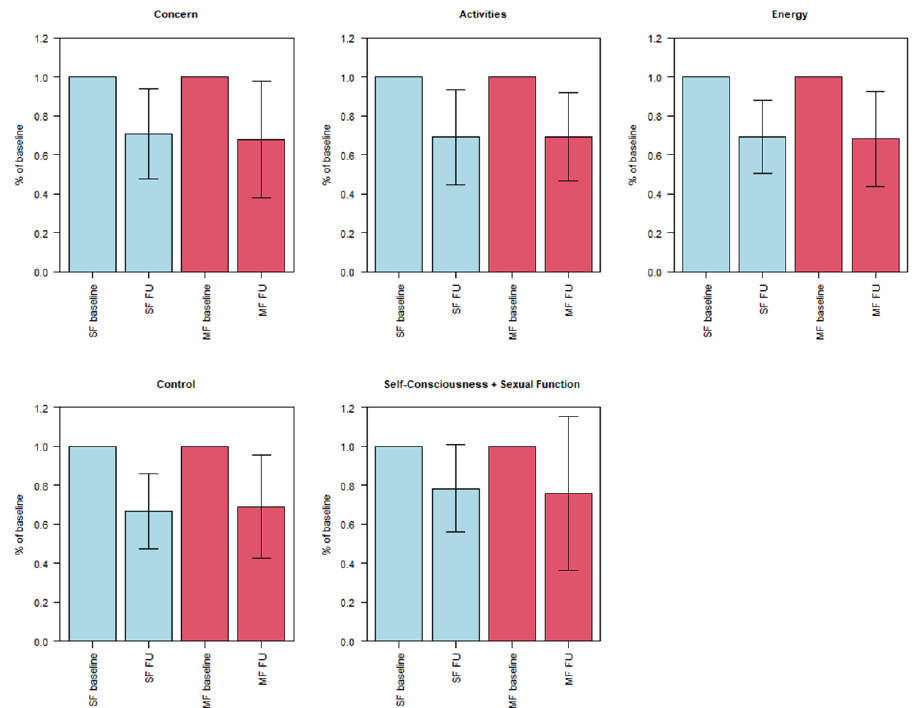
Figure 4. Boxplots showing minimum, first quartile, median, third quartile and maximum for scores of UFS-QOL items: concern, activities, energy/mood, control and combined self-consciousness and sexual function. Both scores of 6-month FU were normalized to baseline scores. Differences between baseline and 6-month FU were significant for both SF and MF groups regarding concern, activities, energy/mood, and control. No significant difference was found for the MF group in self-consciousness and sexual